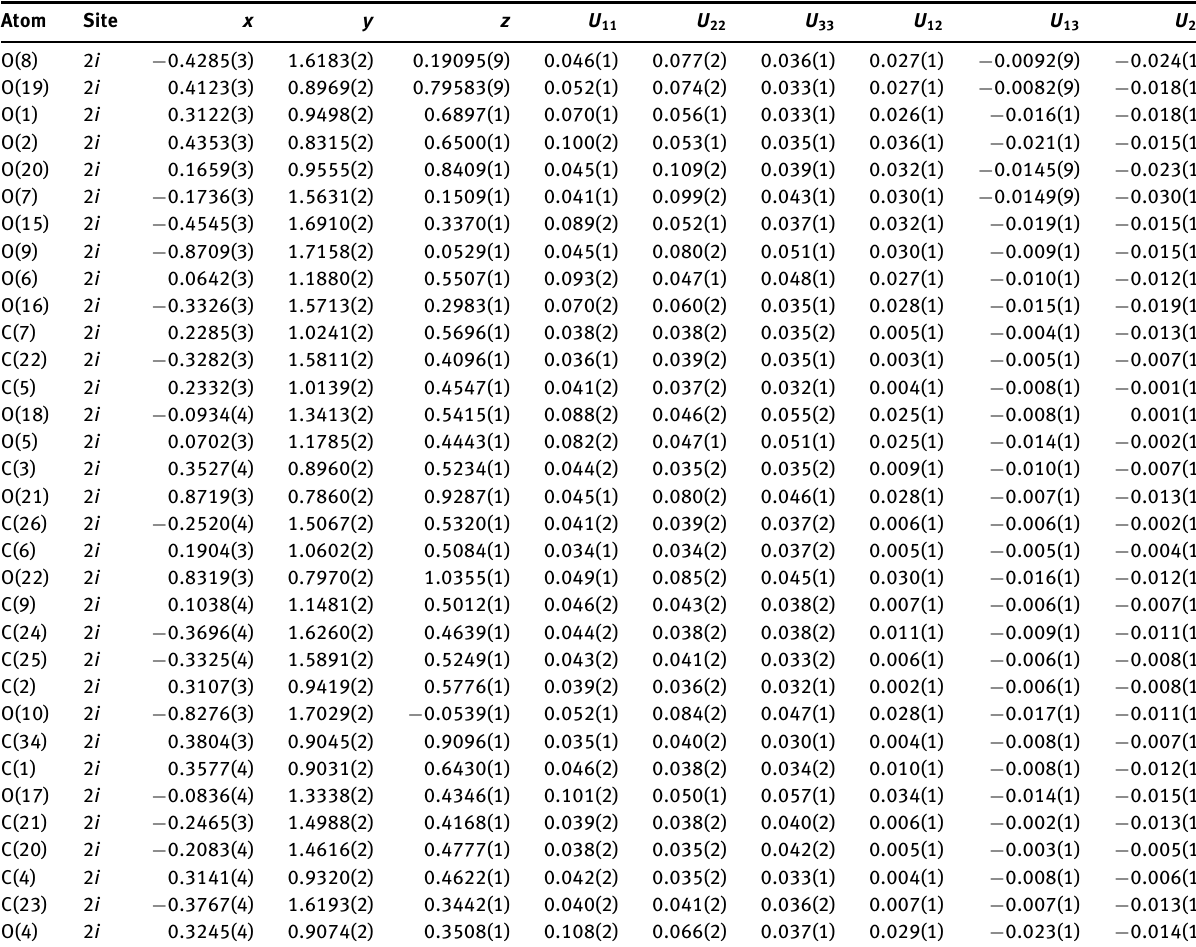
Table 3: Atomic displacement parameters (Å 2